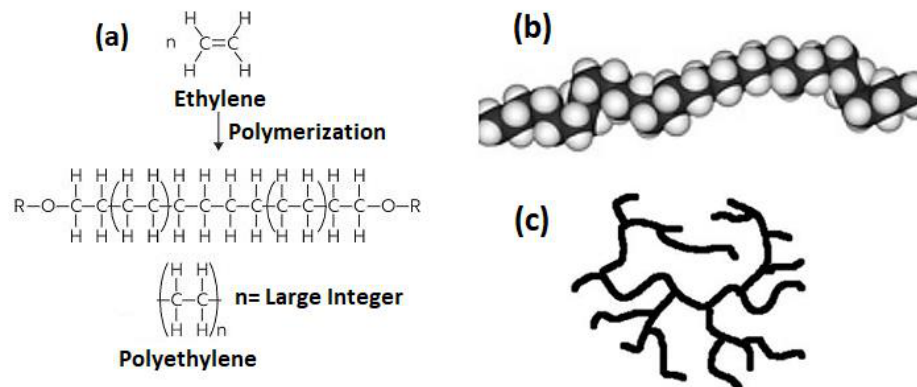
Figure 4. ( a ) Concept of free radicals, ( b ) space-filling, and ( c ) the chemical structure of high-density plastics.